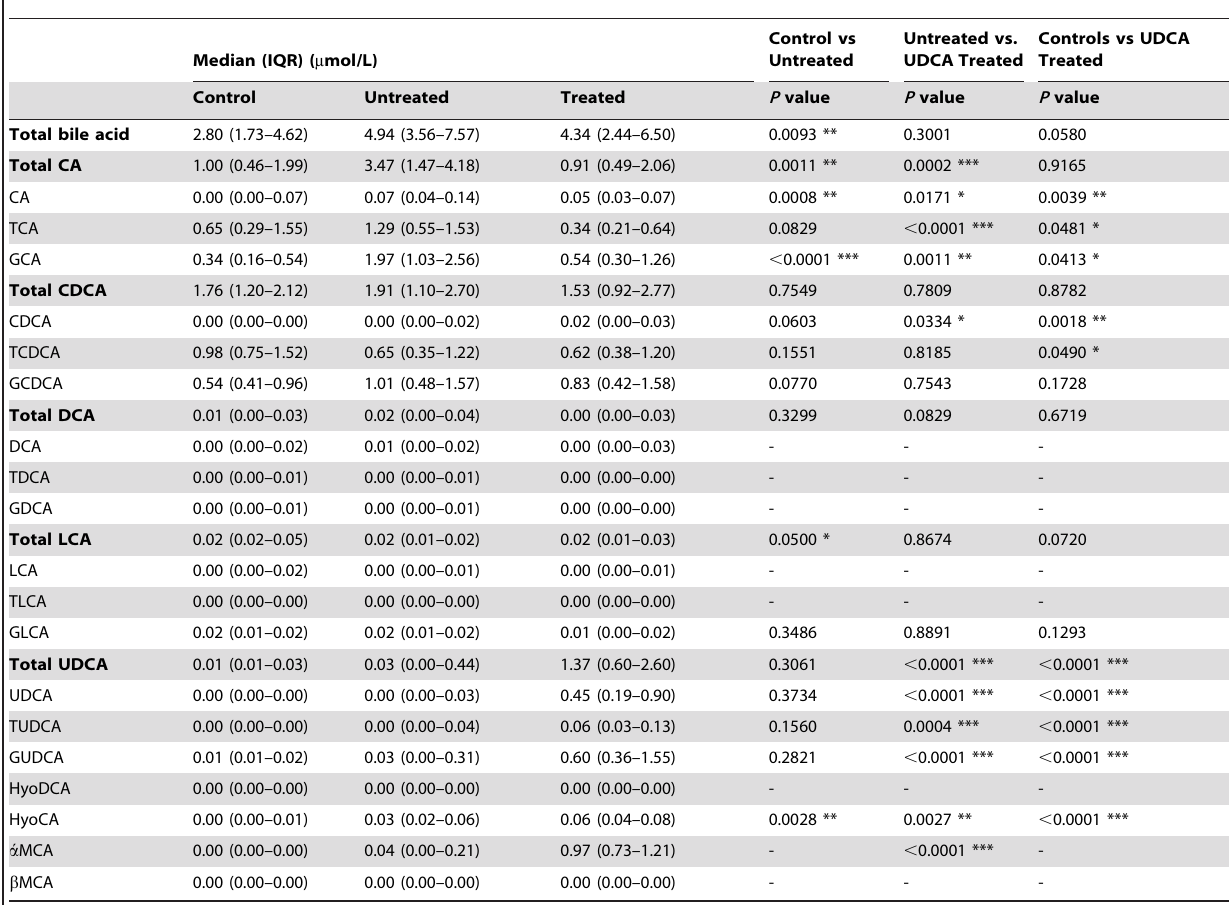
Table 4. Comparisons of bile acid profiles in fetal